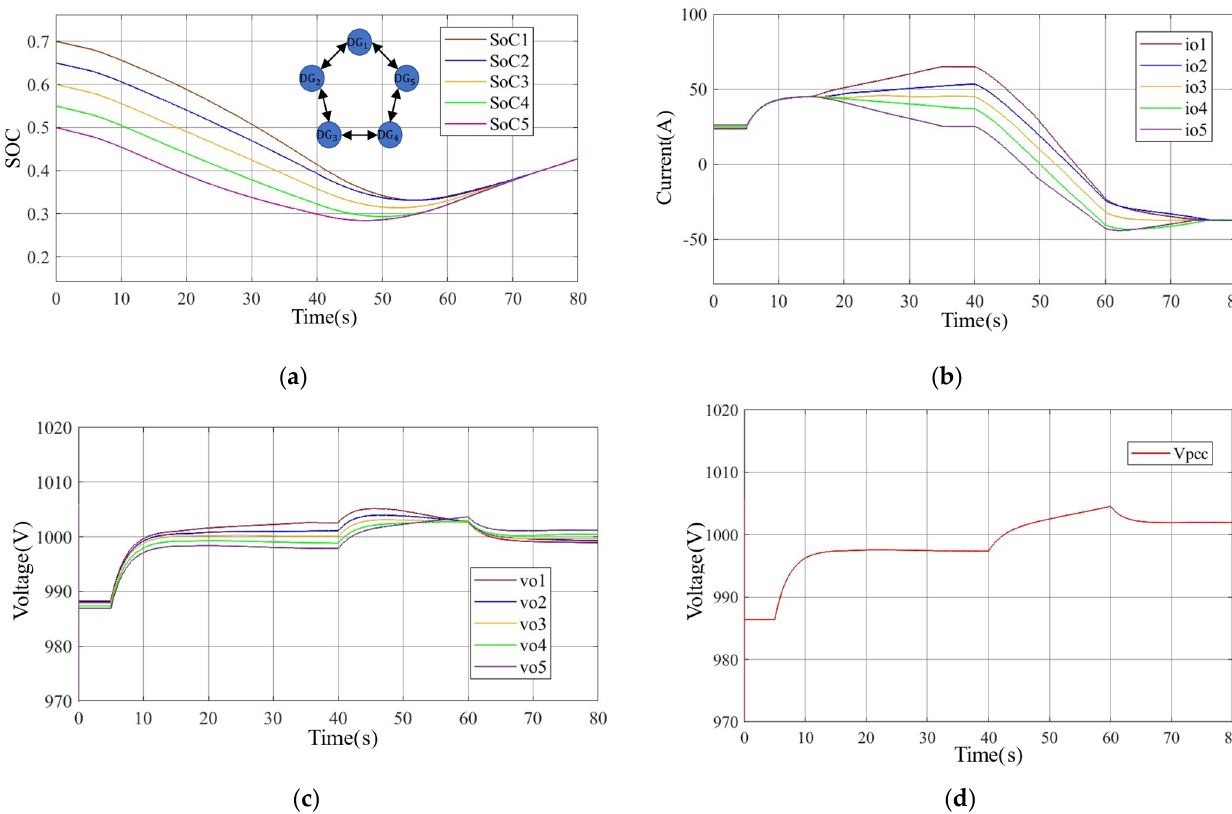
Figure 9. Simulation under the proposed strategy: ( a ) state of charge of batteries; ( b ) output current of converters under secondary control; ( c ) output voltage of converters under secondary control; ( d ) DC bus voltage under secondary control.